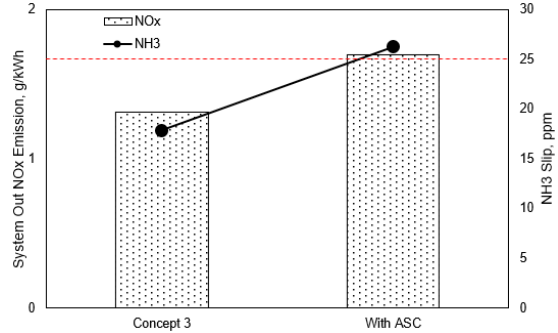
Figure 6. NOx emission results and NH 3 slip results considering ASC concept.